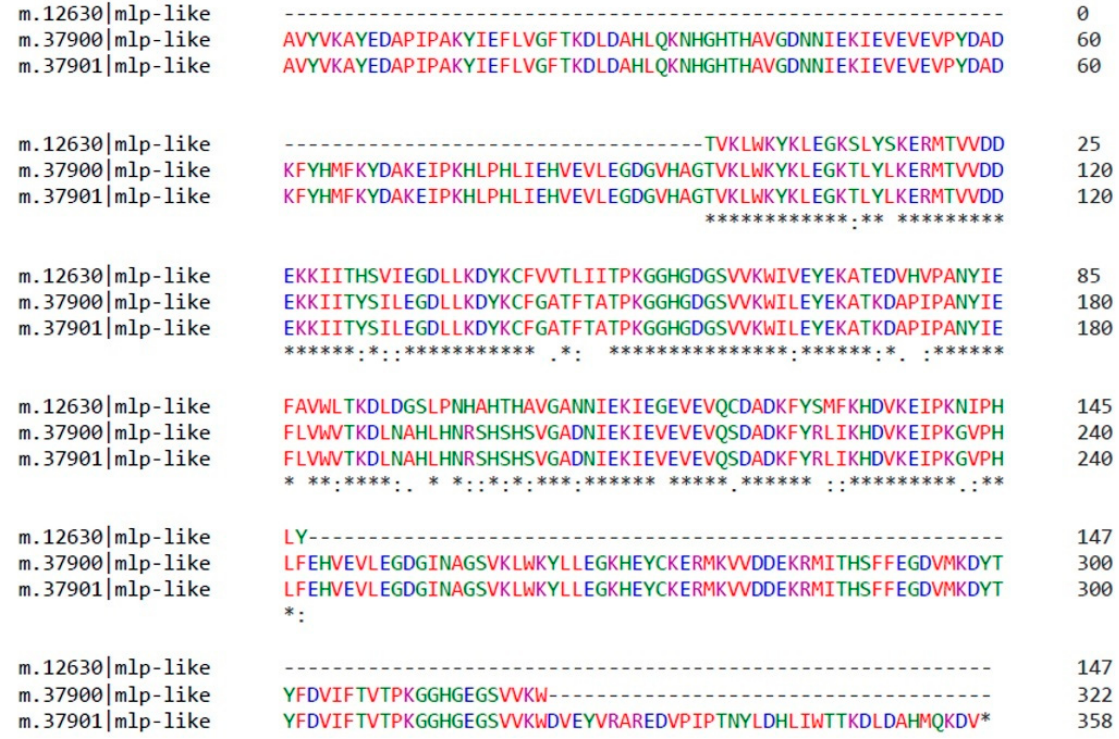
Figure 5. Primary sequence alignment of three C. majus MLPs. The protein sequence is shown, with the number of amino acids for each sequence. Asterisks indicate conserved amino acids with the “core” common to all sequences. The shortest MLP-like m.12630 sequence contains 147 residues and has molecular weight of 16.77 kDa. C. majus database accession numbers are shown.